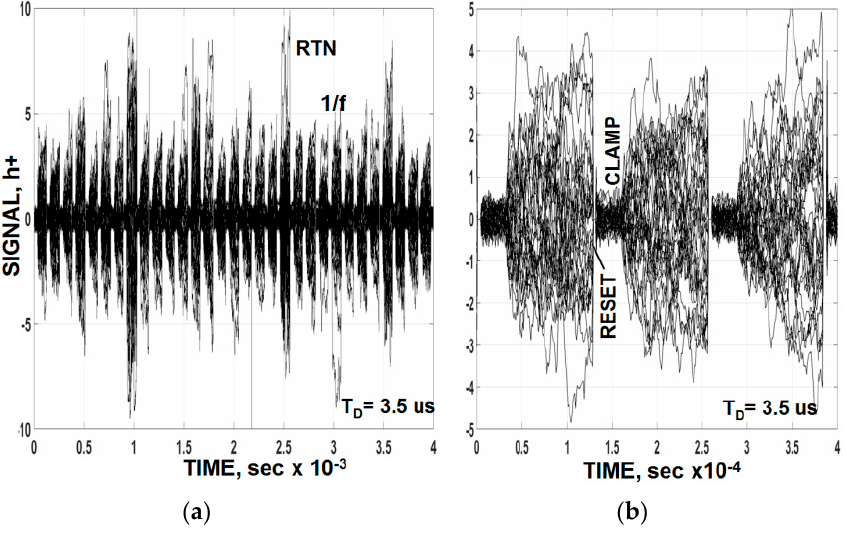
Figure 12. Raw video showing how noise increases after clamp is released for several pixels. ( a ) stacked raw clamped dark video plots; ( b ) magnified plot.